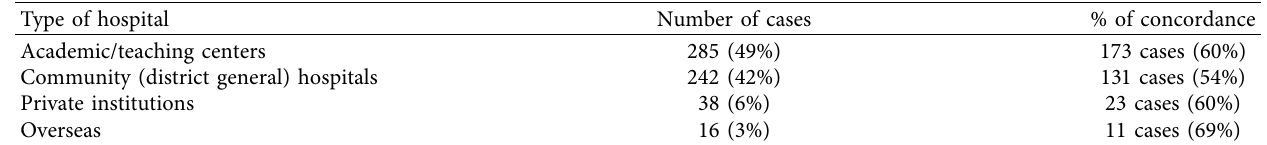
Table 9: Percentage of diagnostic concordance according to type of referring